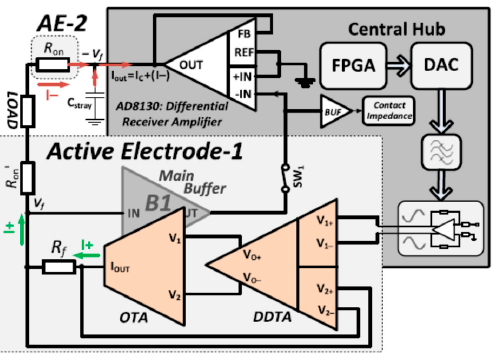
Figure 12. Current driver topology with sink current provided from central hub (Reproduced from [21] with permission from the IEEE).